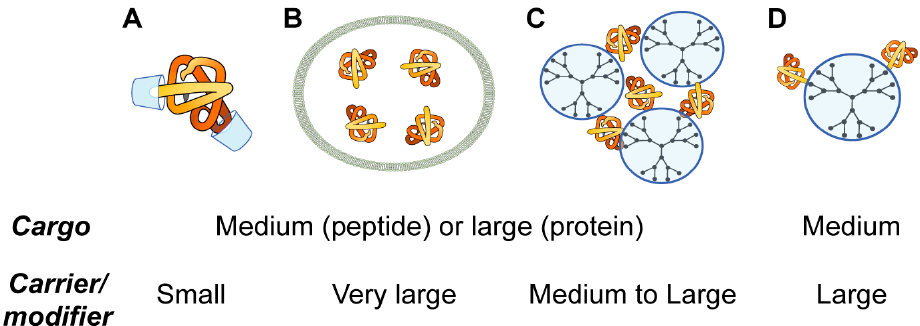
Figure 4. Topological groups of nanoformulations for peptide and protein delivery: modification of polypeptide chains by host-guest interactions with cavitands ( A ); packaging of proteins and peptides into liposomes ( B ); complexation with dendrimers ( C ); and conjugation with dendrimers ( D ). Table 1. Advantages and disadvantages of the topological types discussed.